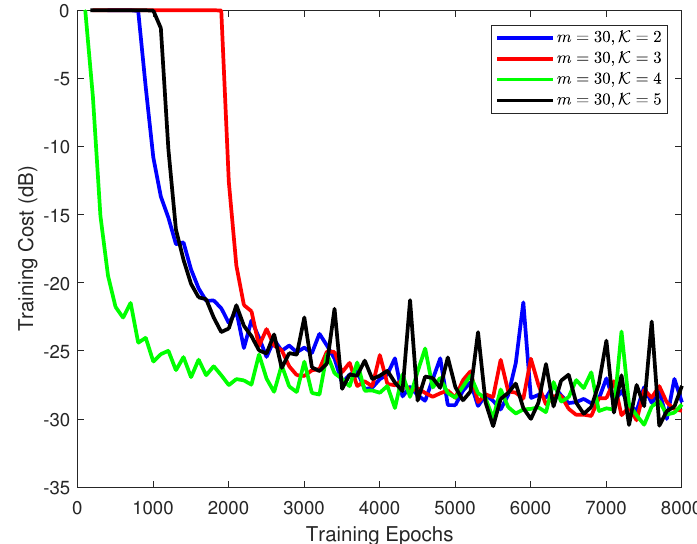
Figure 4. The cost performance comparison under different kernel